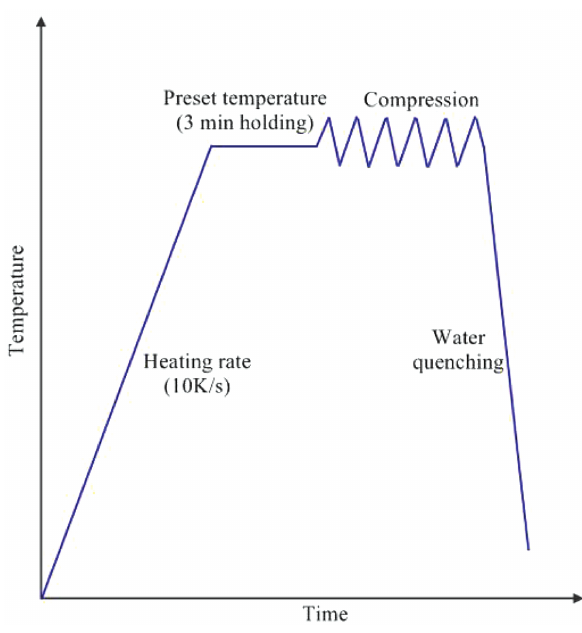
Figure 2: Experimental procedure of hot compression